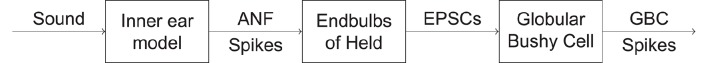
Structure of the GBC model. ANFs converge onto a soma of a GBC and excite it through large synapses (endbulbs of Held).